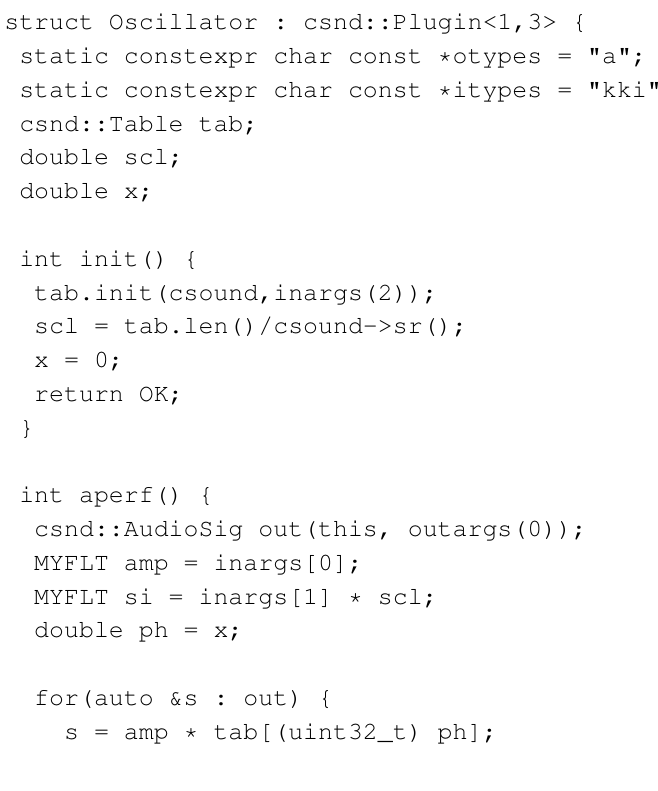
Listing 7: Table-lookup oscillator opcode